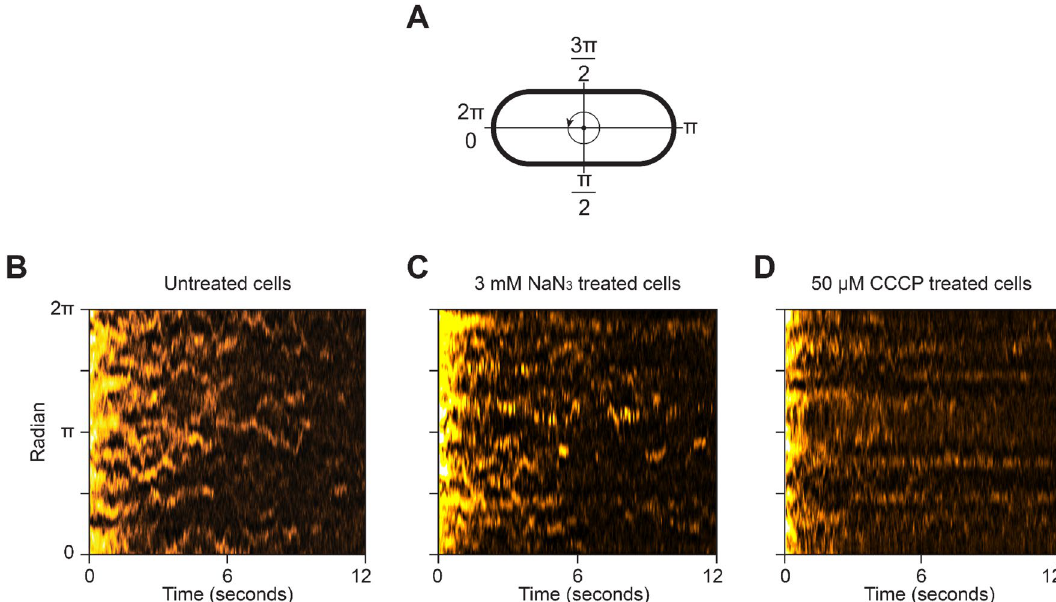
Figure 5. In vivo motion of SecA at the cytoplasmic membrane. ( A ) model of a cell outline with polar coordinates indicating the radians displayed at the kymographs. ( B – D ) Kymographs of the SecA-Ypet fluorescence along the cytoplasmic membrane under native and treated conditions. Movement of foci along the membrane results in diagonal lines where reoccurrences at the same location over time appears as horizontal